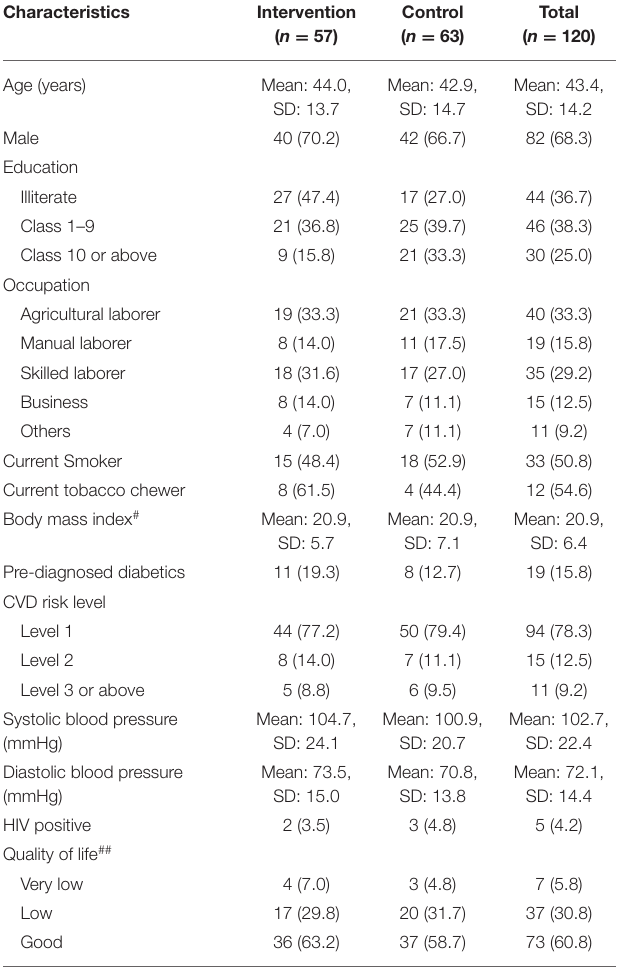
TABLE 1 | Baseline characteristics of study respondents in intervention and control group.